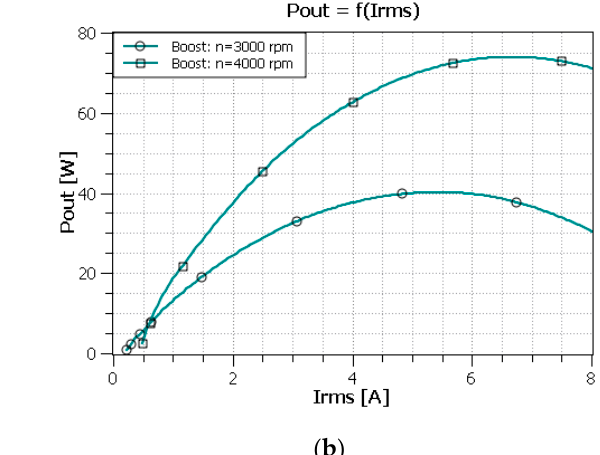
Figure 7. Simulation circuit of the two-switch converter.